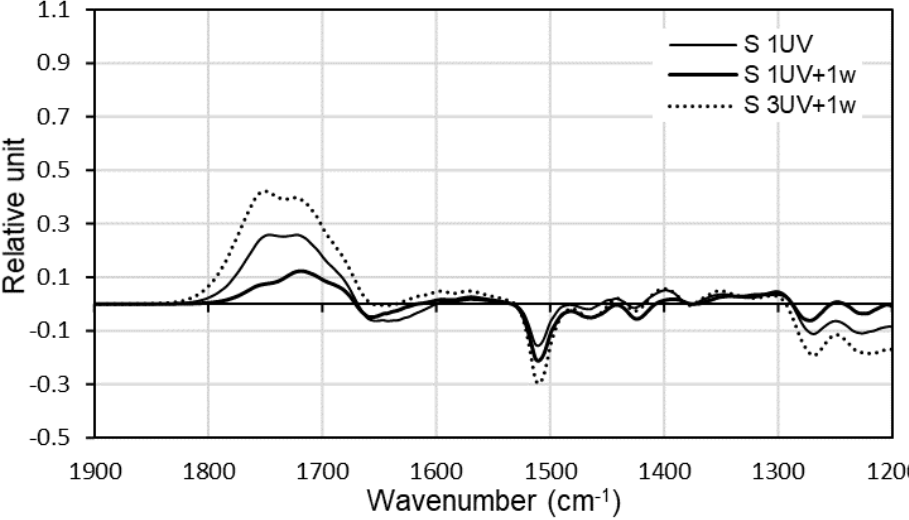
Figure 4. Difference FTIR spectra of spruce (S). 1 UV = one-day UV irradiation; xUV + yw is an abbreviation where x is the extent of UV irradiation, and y is the extent of water leaching in days.